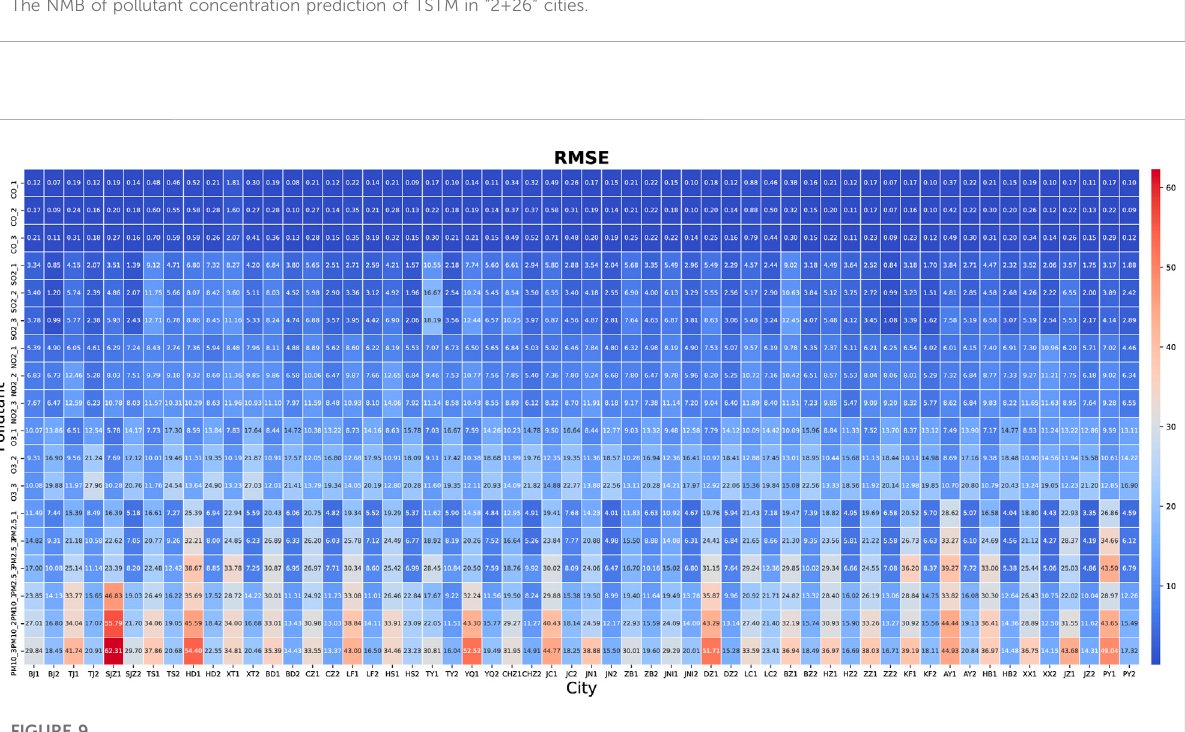
FIGURE 9 The RMSE of pollutant concentration prediction of TSTM in “ 2+26 ” cities (unit: mg/m 3 for CO, μ g/m 3 for other